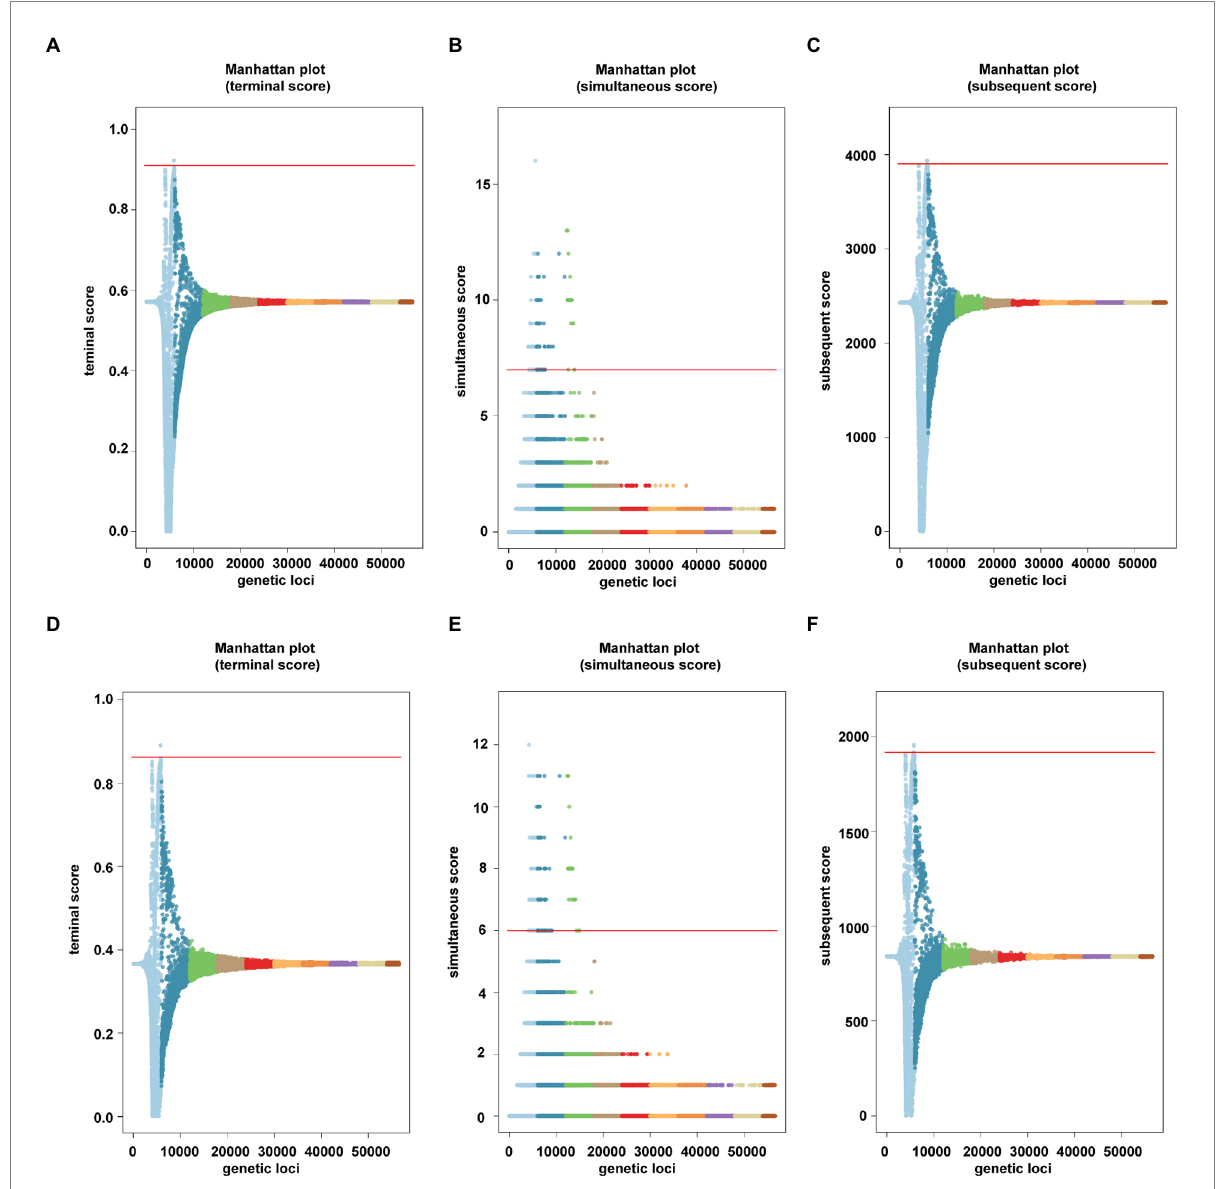
FIGURE 2 Manhattan plots of the two carbapenems under treeWAS score [ (A–C) were for IPM, and (D–F) were for MEM]. Manhattan plots for (A,D) terminal score, (B,E) simultaneous score 2, (C,F) subsequent score showing association score values for all genes, a significance threshold (red), above which points indicate significant